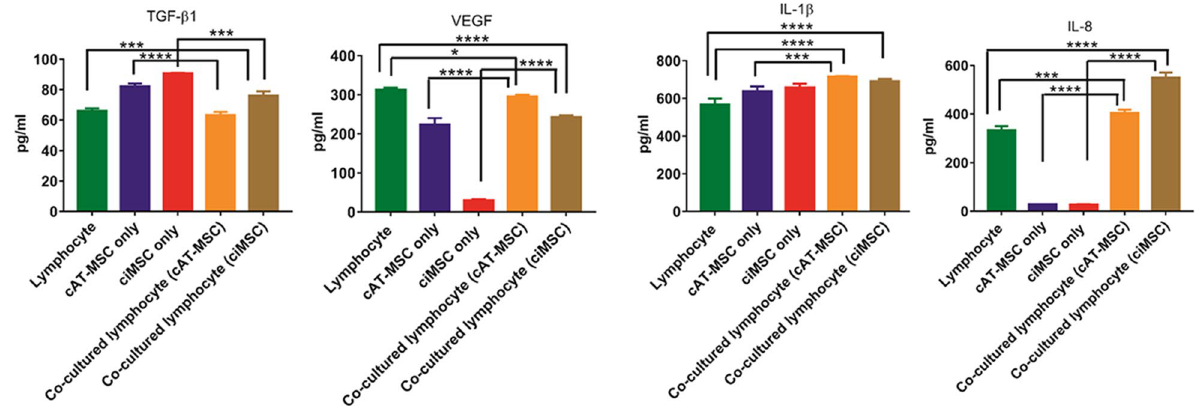
Figure 6. Effects of co-culture on the secretion of factors by lymphocytes, ciMSCs and cAT-MSCs. Lymphocytes, ciMSCs and cAT-MSCs produce IL-1β, IL-8, TGF-β1 and VEGF. Based on mRNA levels (see Figs. 5 and 6), the increase in IL-1β measured in the medium from co-cultures of cMSCs and lymphocytes is likely produced by the ciMSCs and cAT-MSCs rather than the lymphocytes. When similarly referenced to mRNA levels, cAT-MSCs and lymphocytes in co-culture upregulate their expression of IL-8 while ciMSCs do not. Significance is defined as: * p ≤ 0.05; ** p ≤ 0.005; *** p ≤ 0.0002; **** p ≤